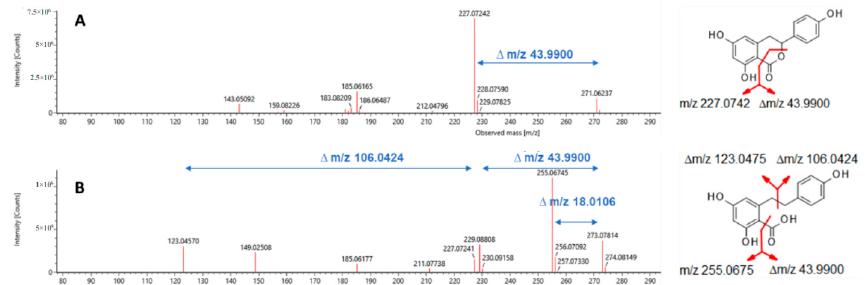
5 of 16 Figure 2. HSCCC chromatogram of the ethyl acetate fraction. Vertical lines represent combined fractions. 2.3. Dihydro-Isocoumarins The application of the methods reported in 2.1 and 2.2 yielded in a total of 13 dihydrocoumarins (8 glycosides and 5 aglyca). In addition to the quantitatively dominating compounds hydrangenol-8-O-glc ( 1 , 62 mg), thunberginol G-3 ′ -O-glc ( 2 , 12 mg), and phyllodulcin-8-O-glc ( 3 , 21 mg), also some minor compounds hydrangenol-4 ′ - O-glc ( 4 , 2 mg), phyllodulcin-3 ′ -O-glc ( 5 , 3 mg), thunberginol C-8-O-glc ( 6 , 1 mg), thunberginol E-6-O-glc ( 7 , 5 mg), thunberginol D-6-O-glc ( 8 , 2 mg), thunberginol C ( 9 , 10 mg), thunberginol E ( 10 , 4 mg), thunberginol G ( 11 , 3 mg), hydrangenol ( 12 , 46 mg), and phyllodulcin ( 13 , 20 mg) were isolated (cf. 1D/2D-NMR assignments in Supplementary File S1). In the performed LC-MS measurements all substances revealed similar MS/MS- fragmentation pattern in a spectrum obtained at high energy with common neutral loss cleavages of 43.990 [CO 2 ] as exemplified for thunberginol C ( 9 ) in Figure 3. This neutral loss is related to the α -cleavage of the carbonyl group in the lactone-ring (C-ring) of the dihydro-isocoumarin aglycone. The glycosides showed a typical neutral loss of 162.053 [C 6 H 10 O 5 ] from the cleavage of a hexoside moiety in the spectrum obtained at high energy. Another remarkable feature of the lactone ring is the remaining C-3 stereocenter. Therefore, dihydro-isocoumarins can be distinguished in R - and S - enantiomers. It was reported that dihydro-isocoumarins with a 4 ′ -hydroxyl group such as hydrangenol show